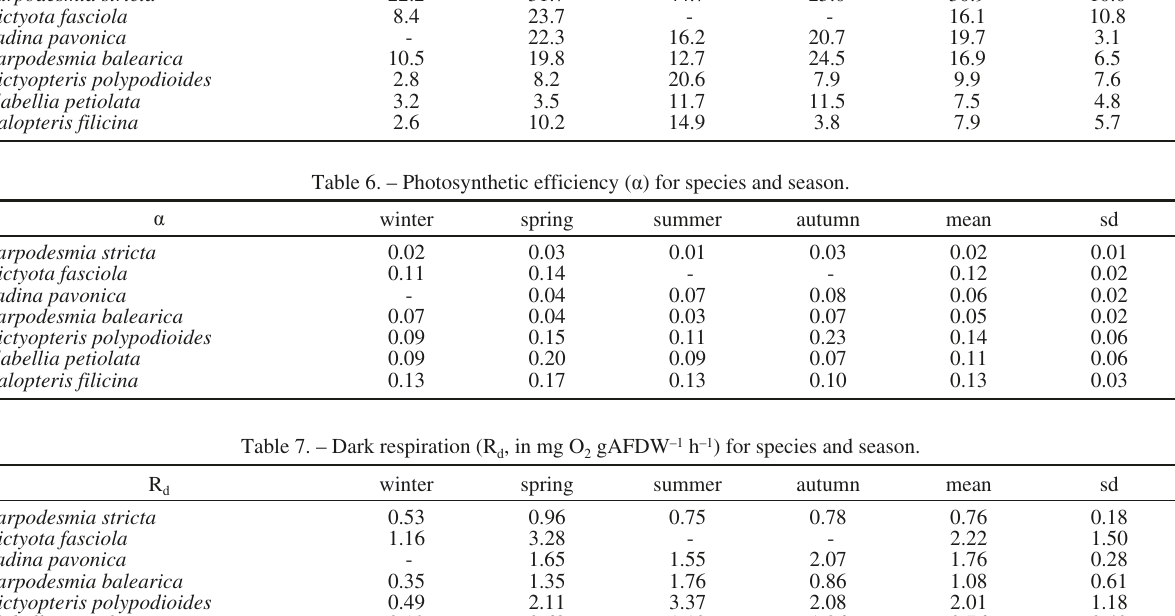
Table 5. – Light at compensation (I